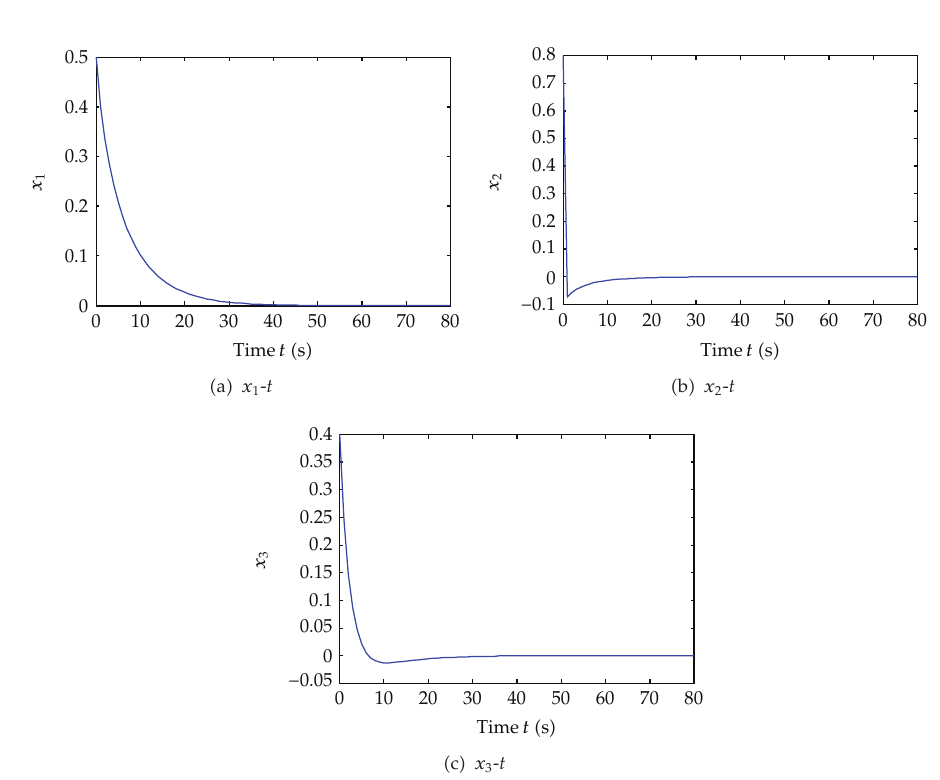
Figure 4: The time domain charts of state variables when the control is applied.